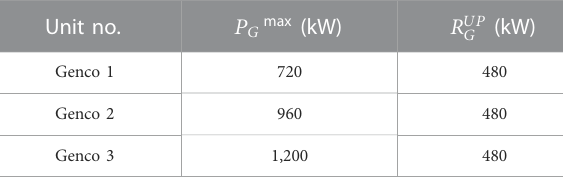
TABLE 2 Parameters of generation company. Unit no.